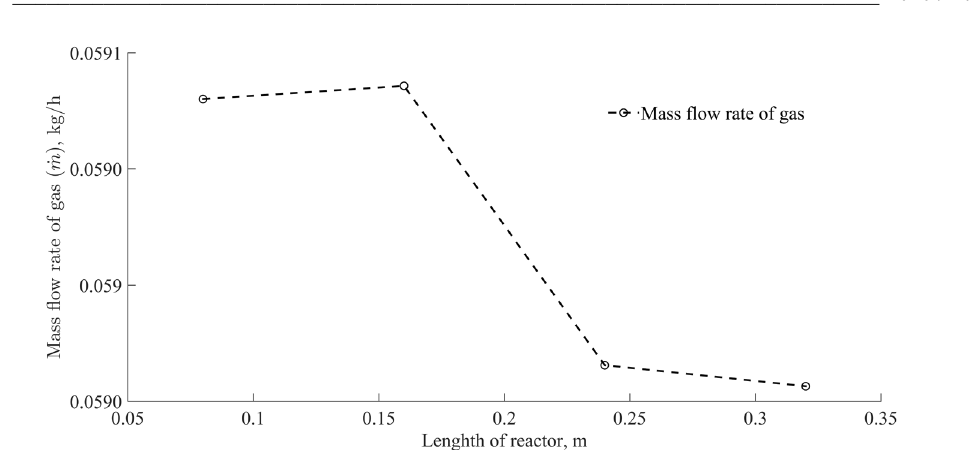
. m ) along the reactor at constant